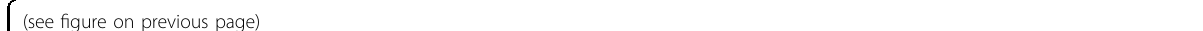
Fig. 2 Performance of a diffractive multispectral imager with N B ¼ 9 spectral bands. a The material thickness distribution of the diffractive layers trained using deep learning to spatially separate 9 distinct spectral bands, creating a periodic virtual fi lter array. b Cross-talk image matrix showing the output images at different illumination wavelengths. Off-diagonal images indicate that the level of spectral cross-talk is minimal. By summing up all the images in each column, the impact of the spectral cross-talk from the other 8 spectral channels on each target wavelength is visualized at the bottom of the image matrix, as a separate row. c Output optical power distribution as a function of the illumination wavelength. Each row in this matrix adds up to 100%, and the off-diagonal optical power percentages indicate the level of spectral cross-talk between different bands. d SSIM and PSNR values of the resulting images at the output of the diffractive network; these image quality metrics were calculated between the diagonal images shown in ( b ) (the ground-truth images on the left diagonal vs. the diffractive network output images on the right